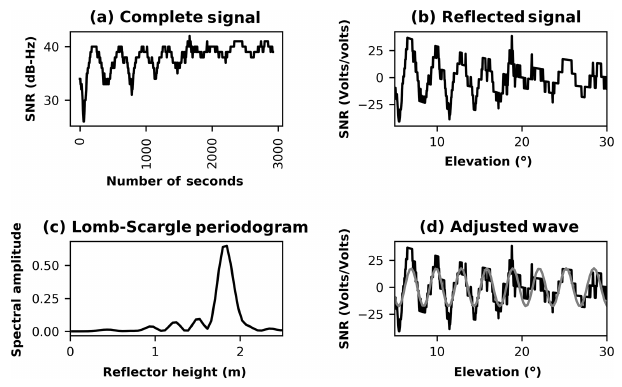
Figure 10. GALILEO satellite no. 21 observed with the mass- market antenna. SNR data in volts (a) , SNR data with the direct sig- nal removed (b) , Lomb–Scargle periodogram for the SNR reflected signal (c) , and SNR reflected signal with the adjusted wave (d)